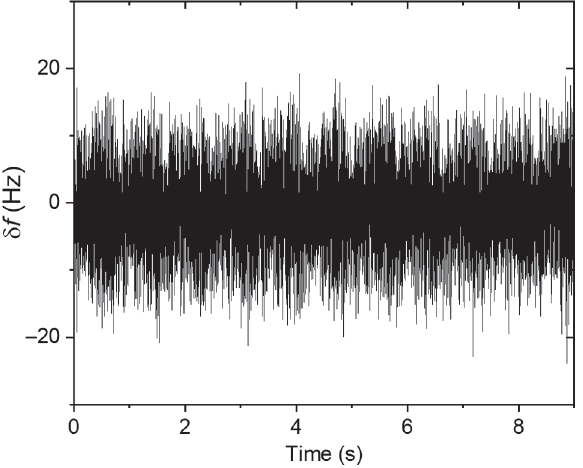
FIG. 30. Snapshot of the shift in the resonant frequency of the prototype cavity inside the HTC, due to microphonics.